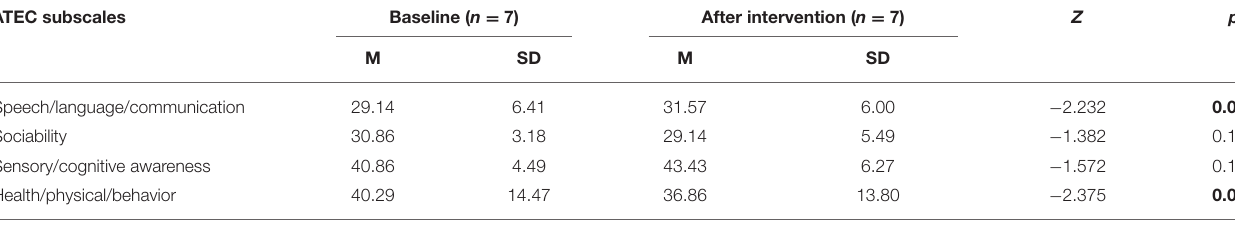
TABLE 3 | Scores of children with developmental disabilities on ATEC at the beginning and the end of the CST pre-pilot program. ATEC subscales Baseline ( n = 7) After intervention ( n = 7) Z p M SD